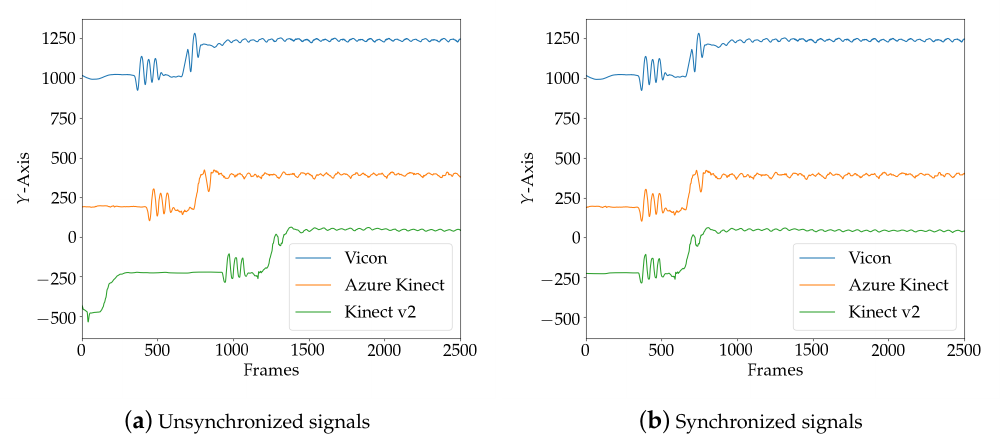
Figure 4. Temporal alignment of Vicon and both Kinect camera signals sampled at 100 Hz. The three consecutive peaks indicate the jumping procedure.